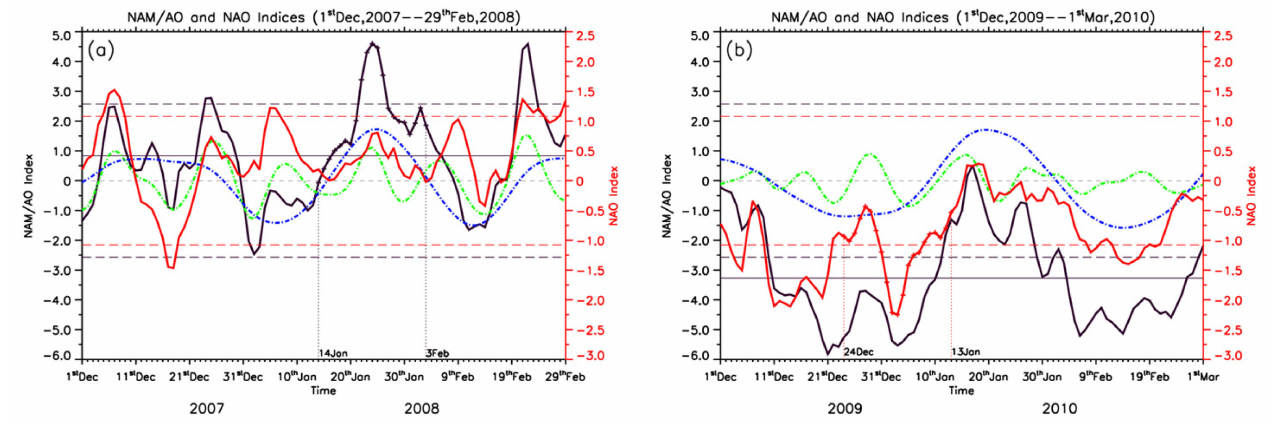
Figure 1. ( a ) The AO/NAM index and the NAO index of the 2007/08 winter. The left vertical axes represent the AO/NAM index and its bandpass filters, and the right vertical axes represent the NAO index. The horizontal axes depict the data. The black (red) solid line represents the AO/NAM (the NAO) index, and the black (red) long-dashed line represents the AO/NAM’s (the NAO’s) 1.33 standard deviation thresholds. The green (blue) dash and dot line represents the band pass of 10–20 days (30–60 days) of the AO/NAM index. The black solid line represents the winter average of the AO/NAM index. The period from 14 January to 3 February 2008, is the positive AO/NAM event. ( b ) The AO/NAM index and the NAO index of the 2009/10 winter. The period from 24 December 2009, to 13 January 2010 is the negative NAO